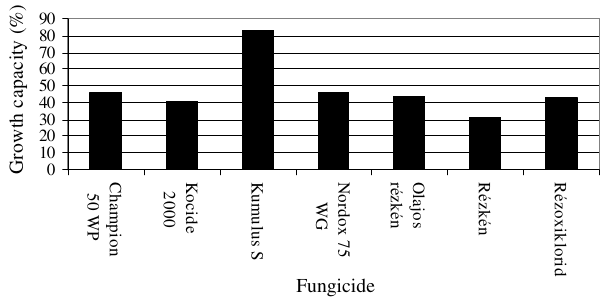
Figure 3. Percent growth capacity of Monilinia laxa for 7 fungicides (organically approved) admended on PDA plates at 0.5 × dosage recommended by the manufacturer (LSD